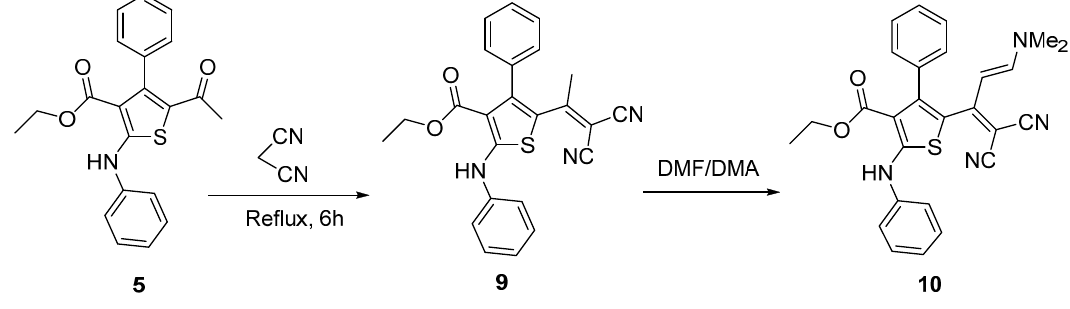
Scheme 3. Synthesis of thiophene derivatives 9 and 10 .